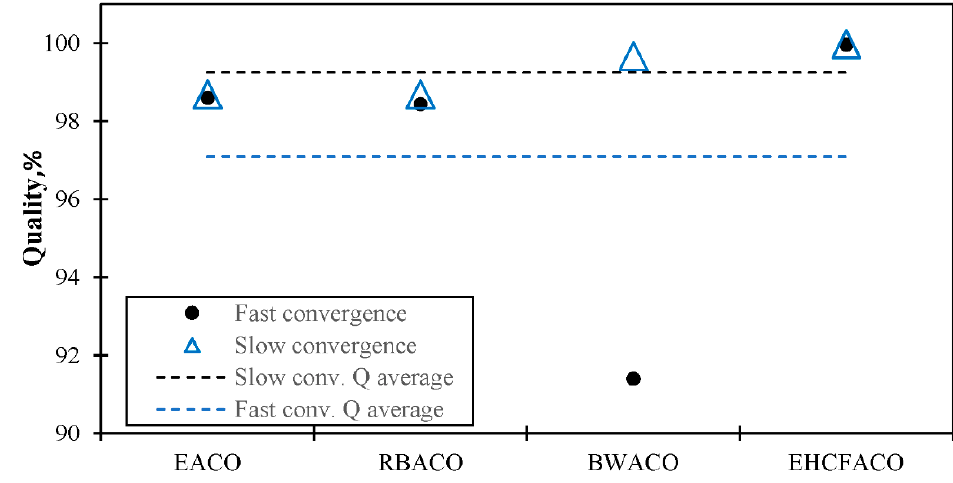
Figure 10. Solution quality of EACO, RBACO, BWACO, and EHCFACO algorithms.